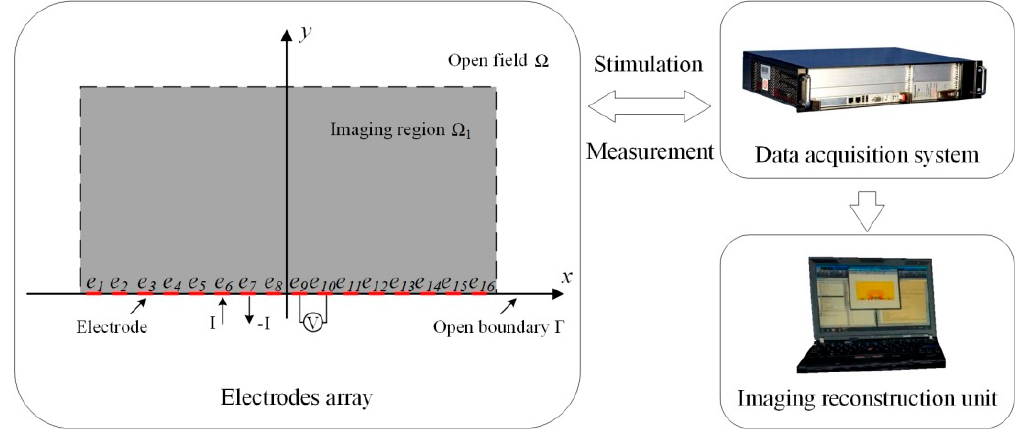
Figure 1. Illustration of the OEIT system with conventional sensor structure.